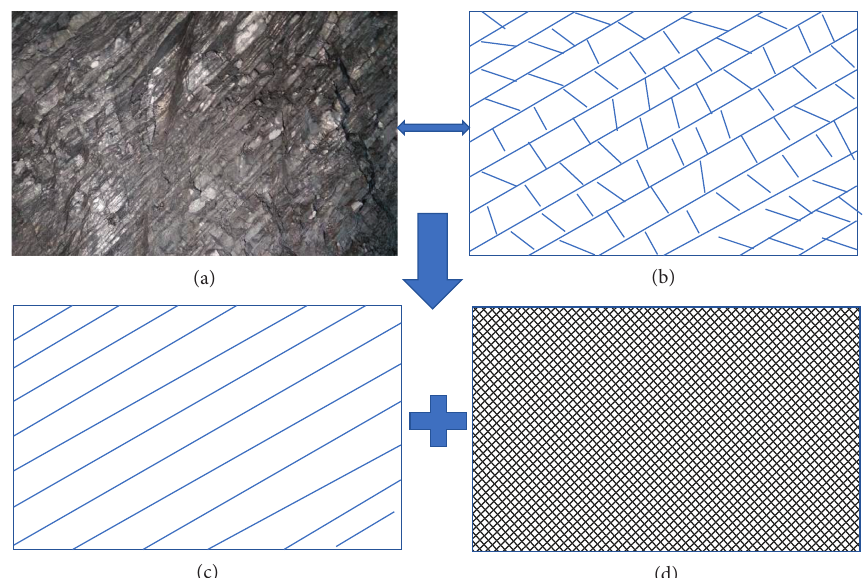
Figure 16: Modeling method of equivalent joints with dominant joints: (a) characteristics of the surrounding rock, (b) generalization of joint distribution, (c) dominant joints, and (d) equivalent ubiquitous